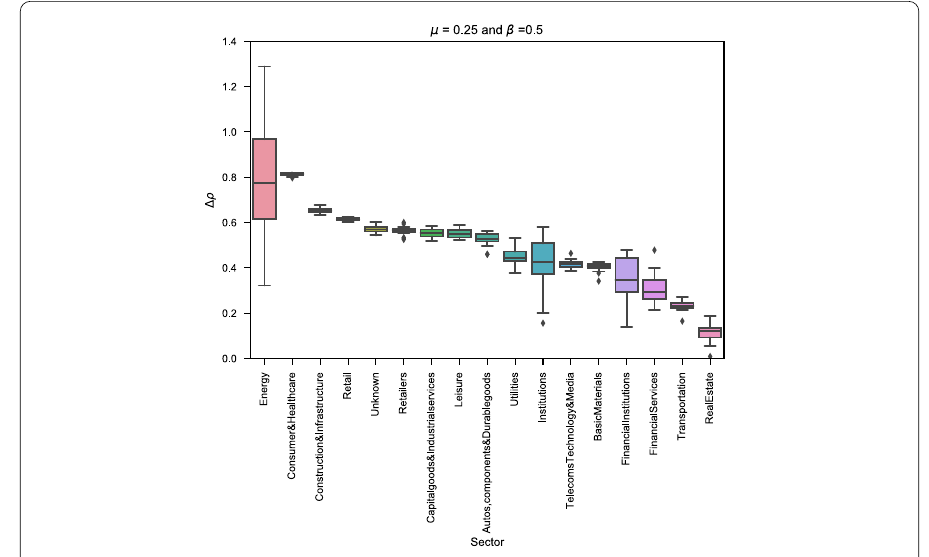
Figure 8 Nullmodelforthesectordefaultdistribution . Sector (cid:3)ρ distribution obtained from rewiring 25 times client-supplier network with μ = 0.25 and β = 0.5